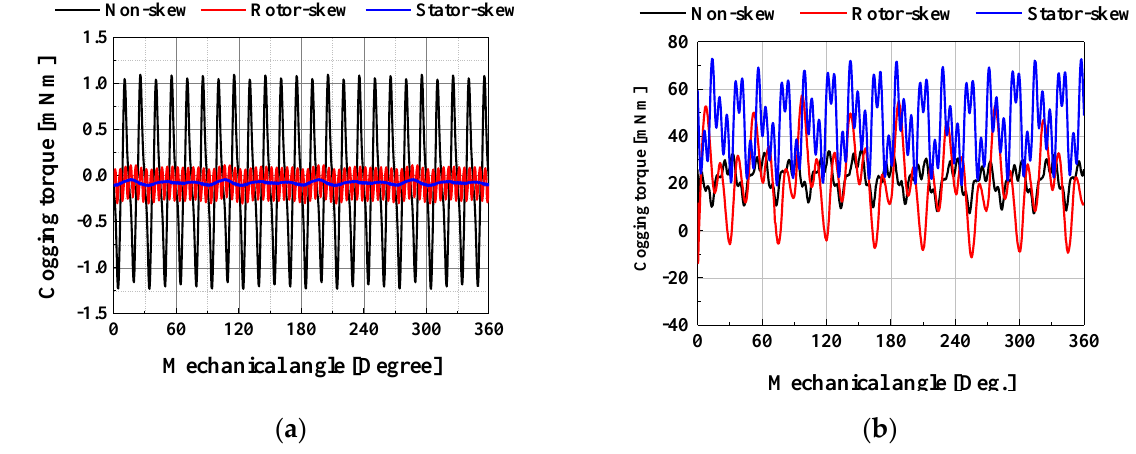
Figure 3. Waveform of the cogging torque for the results of FEA and measurement: ( a ) waveform of cogging torque for the FEA; ( b ) waveform of the cogging torque for the measurement.